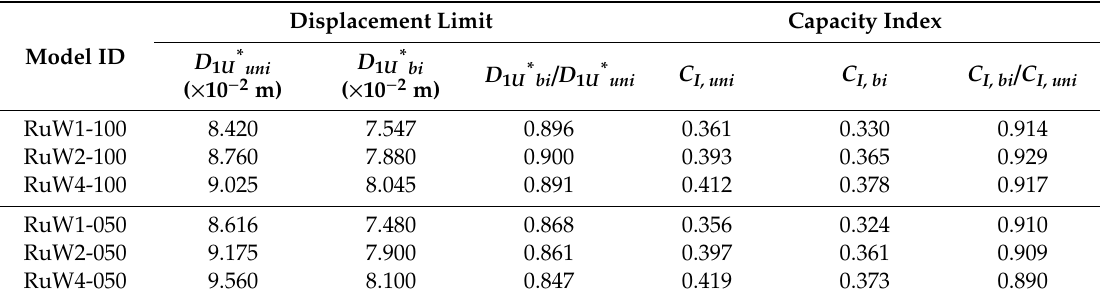
Table 2. Summary of the evaluation results of each model.